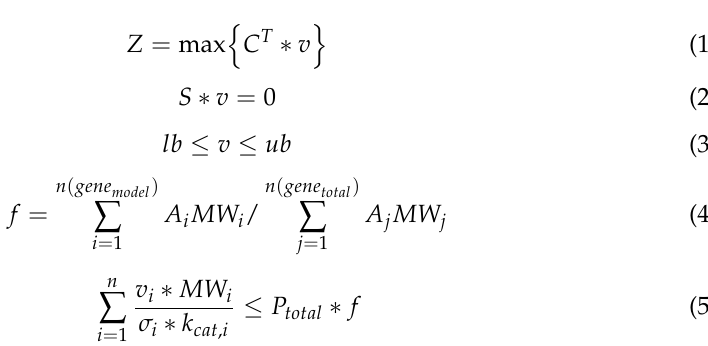
Figure 1. Workflow for the construction of ecCGL1.